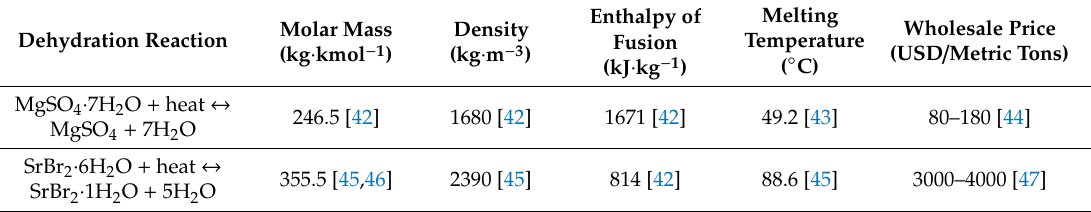
Table 1. Properties of MgSO 4 · 7H 2 O and SrBr 2 · 6H 2